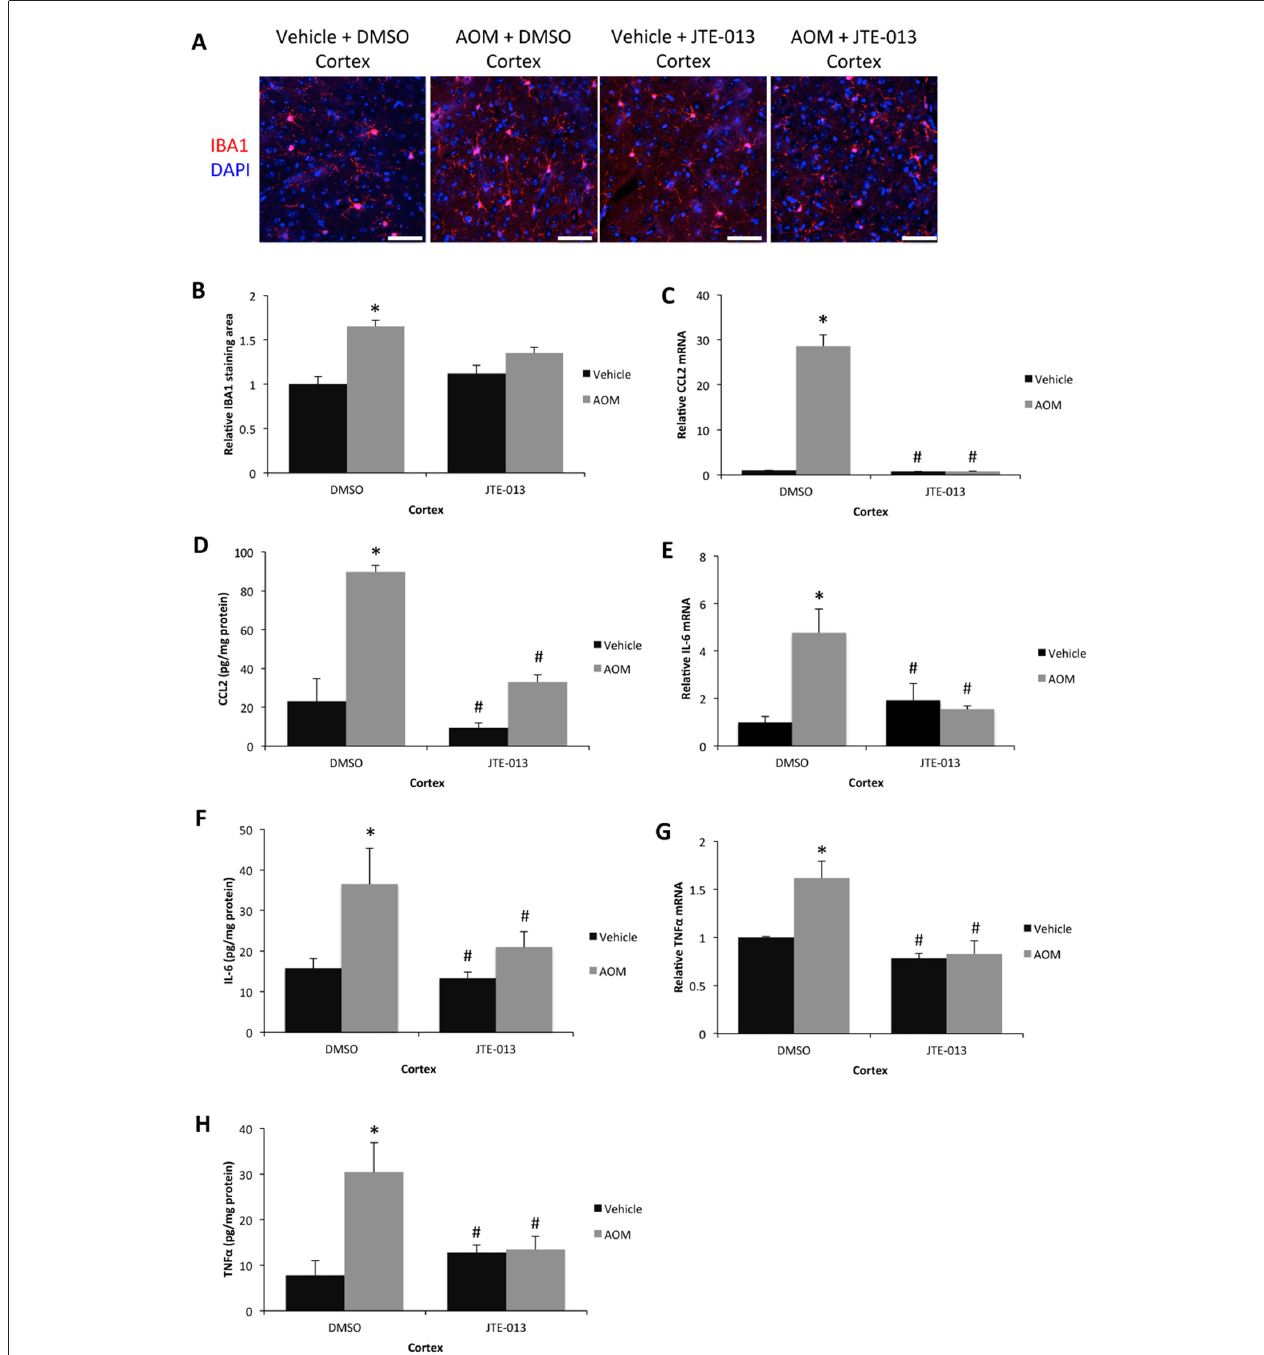
FIGURE 6 | Neuroinflammation can be reduced by JTE-013 infusion. (A) Representative staining for IBA1 (red) in the cortex from DMSO or JTE-013 infused mice administered saline (vehicle) or AOM. DAPI (blue) was used to stain nuclei. The scale bar on the figure represents 50 µ m. (B) Quantification of relative IBA1 field staining in the cortex from DMSO or JTE-013-infused mice administered vehicle or AOM. (C) Relative CCL2 mRNA expression in the cortex from DMSO or JTE-013-infused mice administered vehicle or AOM. (D) CCL2 concentrations in cortex homogenates normalized to total protein concentrations from DMSO or JTE-013-infused mice administered vehicle or AOM. (E) Relative cortex IL-6 mRNA expression in DMSO or JTE-013-infused mice administered vehicle or AOM. (F) Cortex IL-6 concentrations in homogenates normalized to total protein concentrations from DMSO or JTE-013-infused mice administered vehicle or AOM. (G) Relative TNF α mRNA expression in the cortex from DMSO or JTE-013-infused mice administered vehicle or AOM. (H) TNF α concentrations in cortex homogenates normalized to total protein concentrations from DMSO or JTE-013-infused mice administered vehicle or AOM. ∗ p < 0.05 compared to DMSO-infused vehicle-treated mice, # p < 0.05 compared to DMSO-infused AOM-treated mice. n = 3 or greater for all analyses.